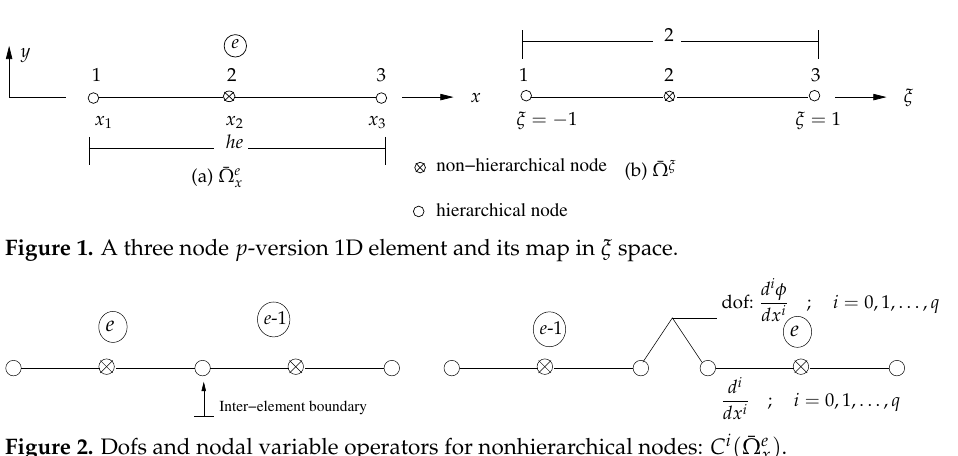
) , the local approximation x must h